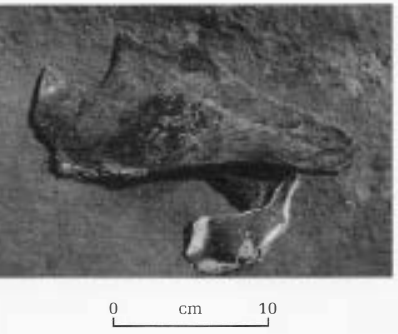
Figure 12 A horse scapula showing (top left) the semicircular shape left by an im­ pact fracture, probably made by a